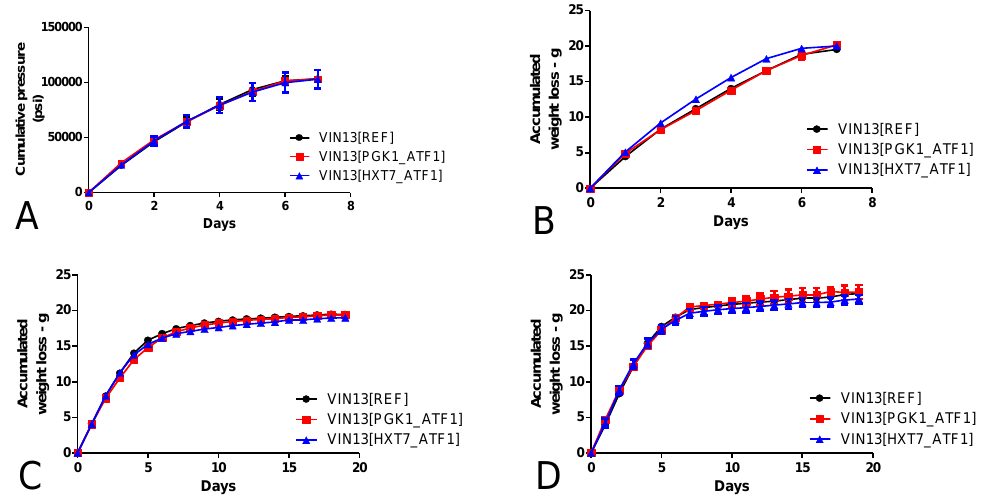
Figure 2. Accumulated weight loss or cumulative pressure of fermentations conducted by the three VIN13 strains using Müller-Thurgau must with the isomixed, closed ( A ), isomixed, open ( B ), static, closed ( C ) and the static, open ( D ) fermentation styles. Fermentations were stopped once no further weight loss was recorded. As the ANKOM Rf system shown in A continuously measures the accumulated pressure within a fermentation, only datapoints corresponding to a 24-h period are shown in the graph. Error bars indicate the standard deviation of four samples.